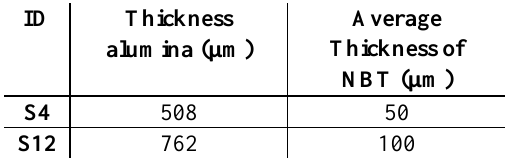
Table 2 : Characteristics of various sample tested ID